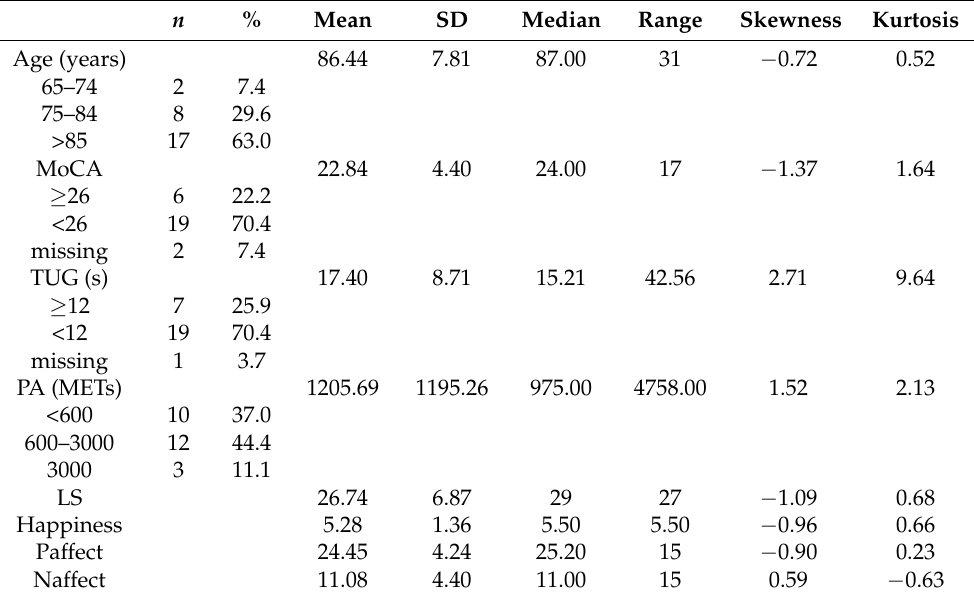
Table 1. Descriptive statistics of baseline characteristics of all participants.